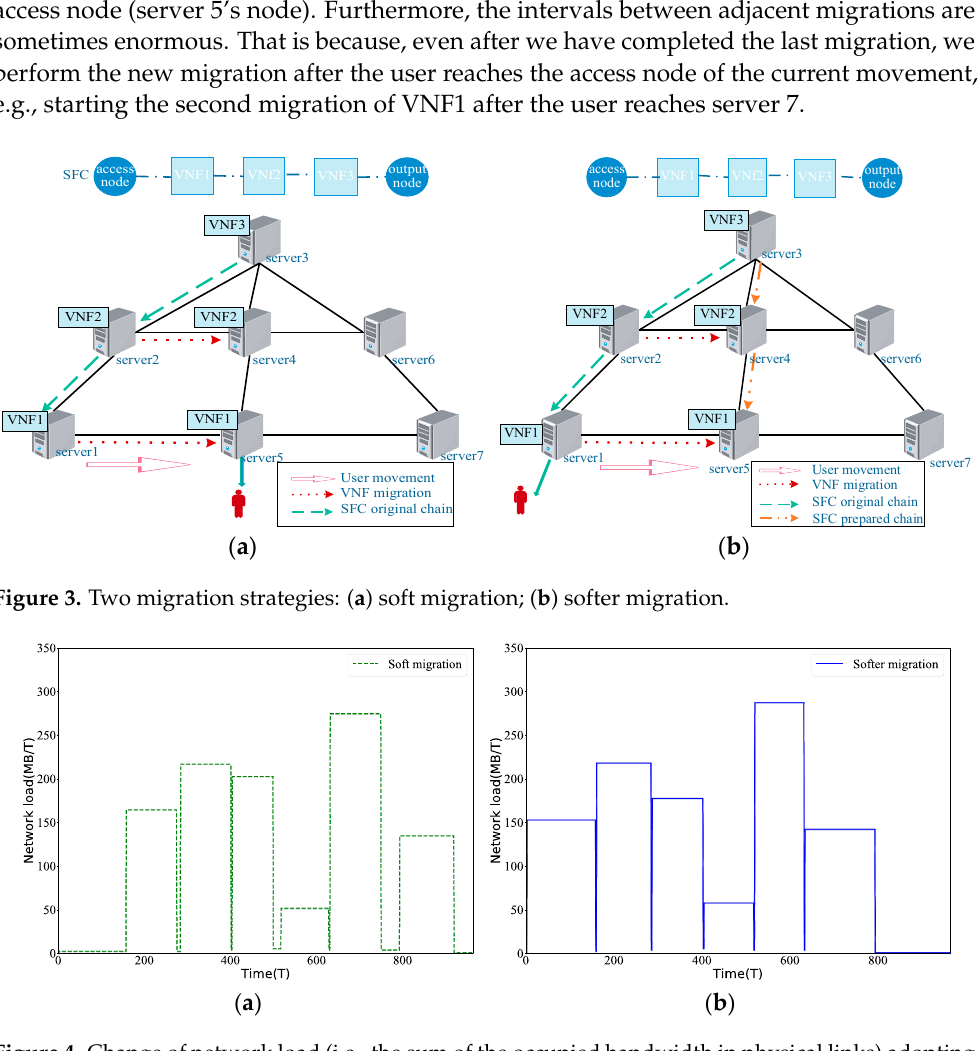
Figure 4. Change of network load (i.e., the sum of the occupied bandwidth in physical links) adopting soft migration and softer migration: ( a ) soft migration; ( b ) softer migration.